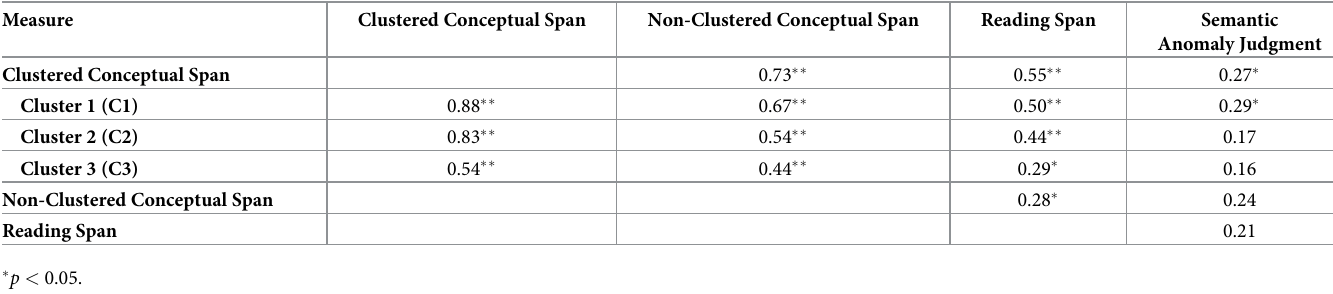
Table 4. Pearson correlations between measures employed in Study